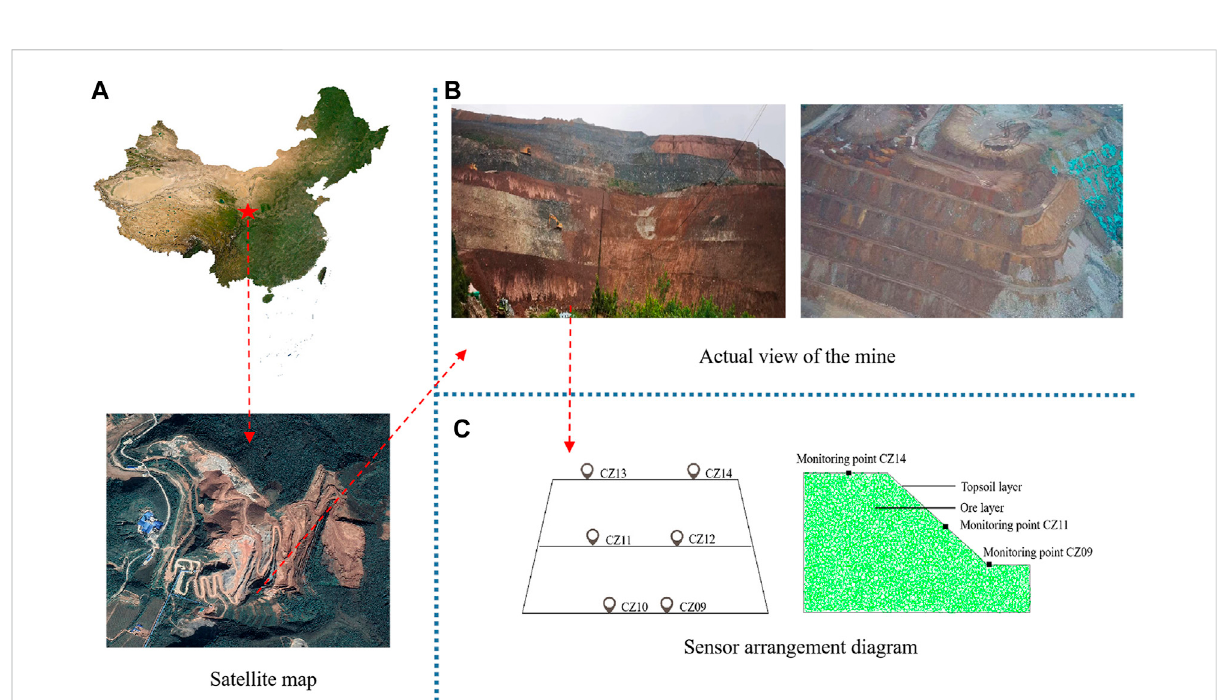
FIGURE 5 Mine location diagram and monitoring point layout